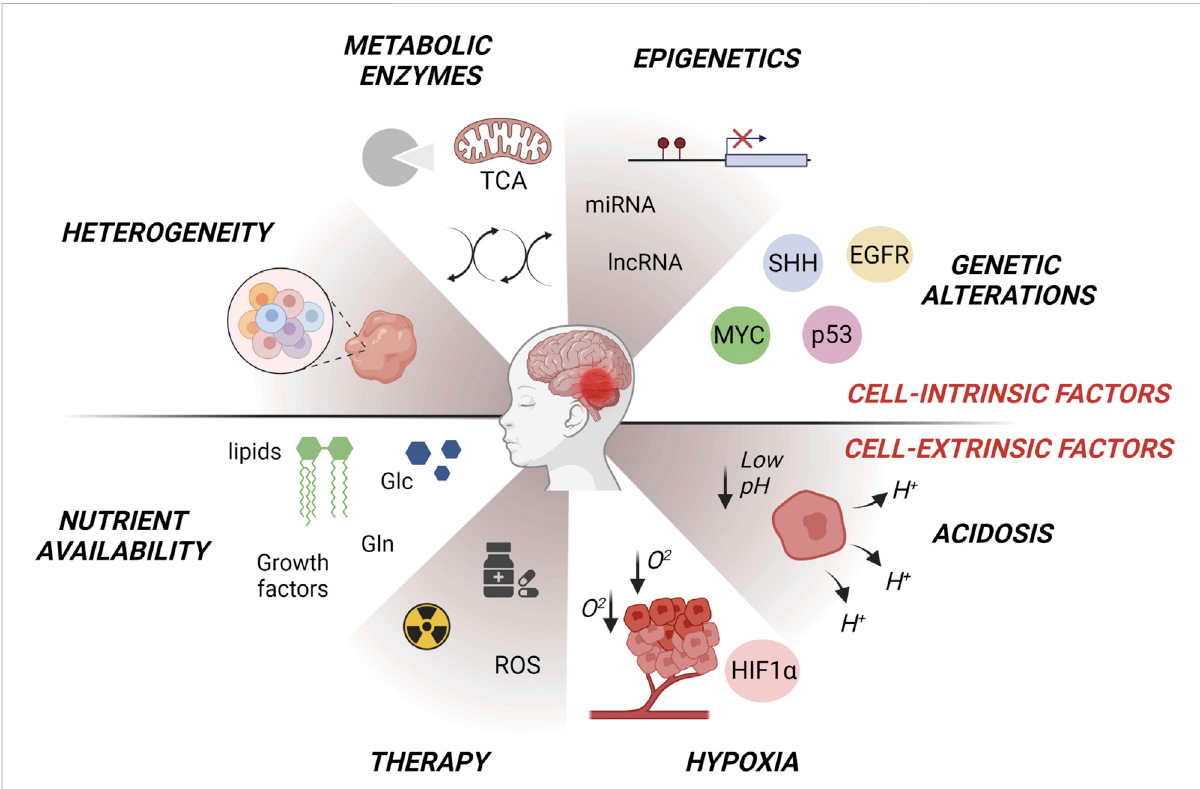
FIGURE 1 Intrinsic and extrinsic factors affecting metabolic changes in MB subgroups (WNT, SHH, Group3, Group4). Tumor intrinsic factors include heterogeneous oncogenic signaling and/or genetic alterations in metabolic enzymes that modulate gene expression through a variety of mechanisms such as signal transduction and epigenetic reprogramming. Tumor extrinsic factors consist of microenvironmental availability of nutrients suchas glutamineoraminoacids, oxygen andchangesinextracellularpH. Alterationsinmetabolism in fl uence glycolysis, lipogenesis, OXPHOS,oxygen reactivespecies (ROS) production, glutamine-dependent signaling and tumorheterogeneity, givingrise to metabolic adaptations. Figure is created in “ BioRender.com ”